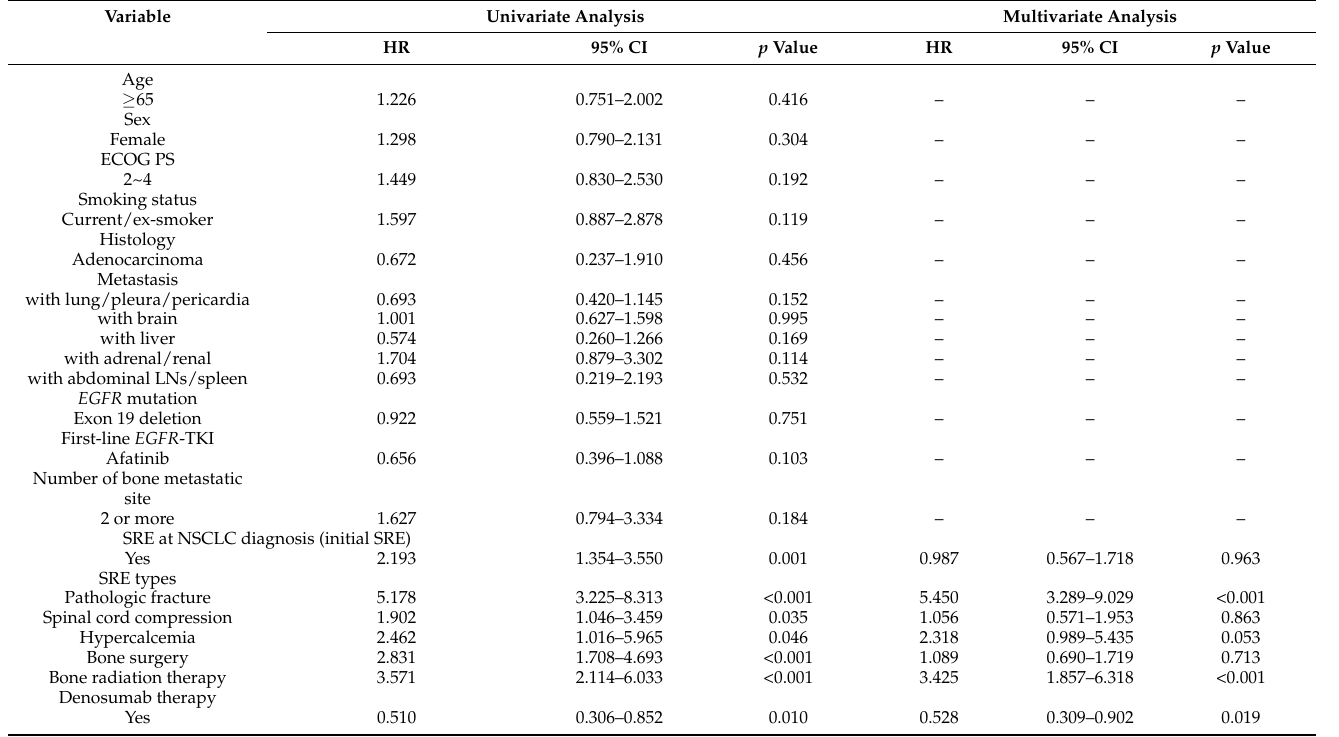
Figure 3. Denosumab effect on subsequent SREs occurrence. ( A ) Cumulative incidence of subse- quent SREs in EGFR -mutated NSCLC patients with bone metastasis with or without denosumab therapy. ( B ) Cumulative incidence of subsequent SREs in EGFR -mutated NSCLC patients with bone metastasis who started denosumab therapy without initial SREs or with/after SREs. CI: confidence interval; EGFR : epidermal growth factor receptor; NSCLC: non-small cell lung cancer; SRE: skeletal-related event. Table 2. Multiple-event analysis * of subsequent SRE occurrence of EGFR -mutated NSCLC patients with bone metastasis.